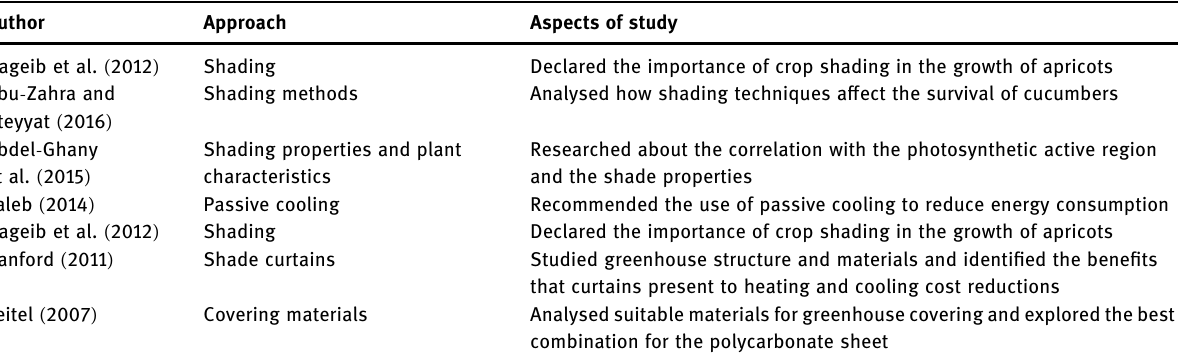
Table 5: Reviewed articles, approaches, and parameters